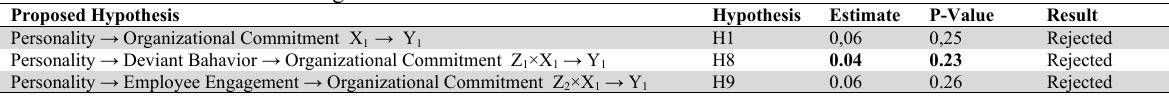
Path Coefficient Moderation